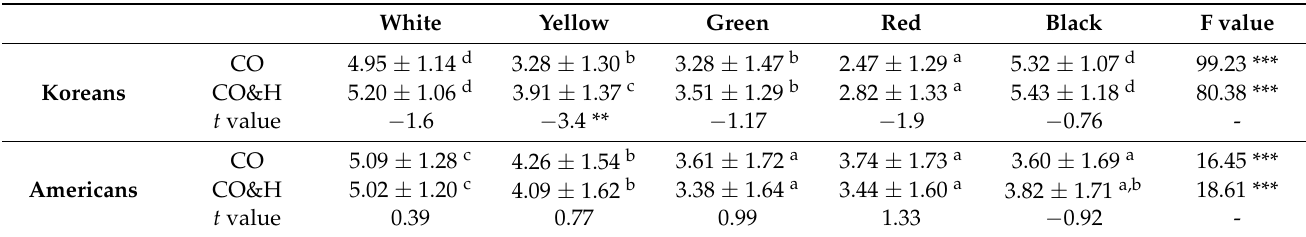
Table 4. Overall liking according to the colors and health functionality information of colored rice in Korean and Ameri- can